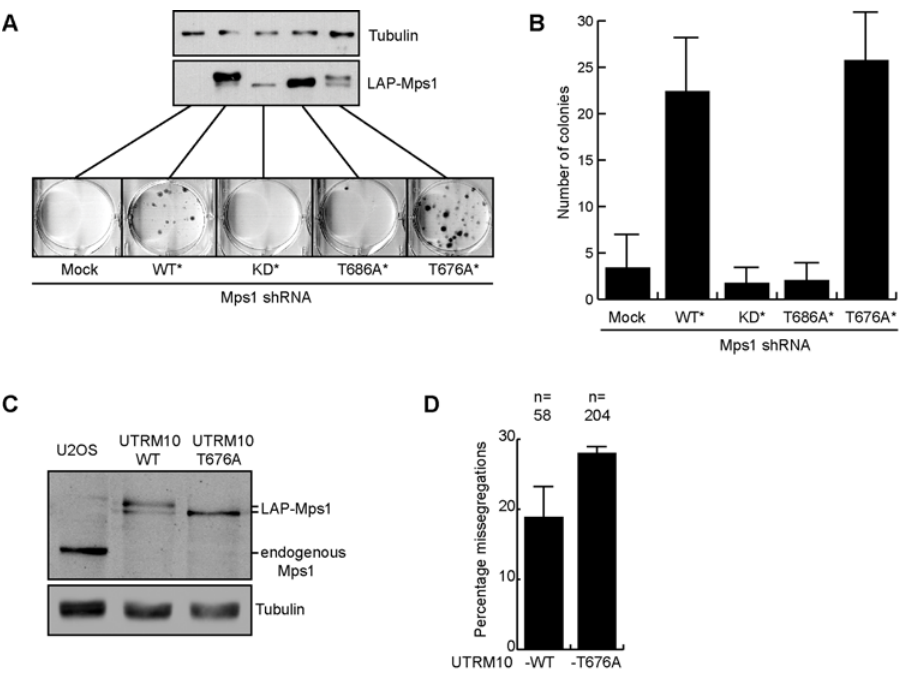
Figure 4. T676 phosphorylation is required for maintaining chromosomal stability but not cell viability. (A) U2OS cells were transfected as in 2B along with pBabe-puro, grown under puromycin selection for two weeks after which surviving colonies were stained. Immunoblot (anti- Mps1) shows expression levels in lysates taken 3 days after transfection of the different LAP-Mps1 mutants. (B) Quantification of the number of colonies counted in 4A, average of three experiments ( + / 2 SD). (C) Immunoblot (anti-Mps1) showing expression levels of endogenous Mps1 and LAP- Mps1 in lysates of U2OS cells, and UTRM10 cells continuously expressing Mps1 shRNA through doxycycline treatment [14] that stably express wild- type LAP-Mps1 (UTRM10-WT) or LAP-Mps1-T676A (UTRM10-T676A). (D) Graph shows average percentages of UTRM10-T676A and UTRM10-WT cells that missegregate chromosomes as observed with live cell imaging (as in 2E), ( + / 2 SD), n=total amount of cells.